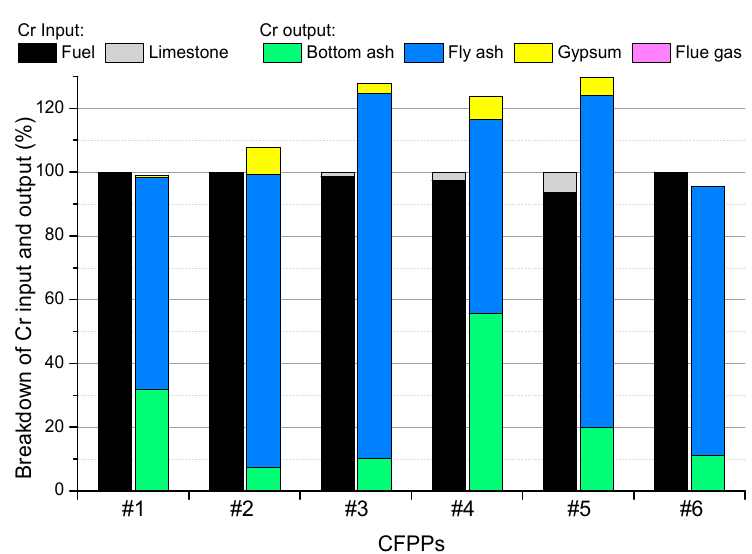
Figure 6. Proportion of Cr in the input and output materials of the six CFPPs (the output ratio is based on the total input of Cr).